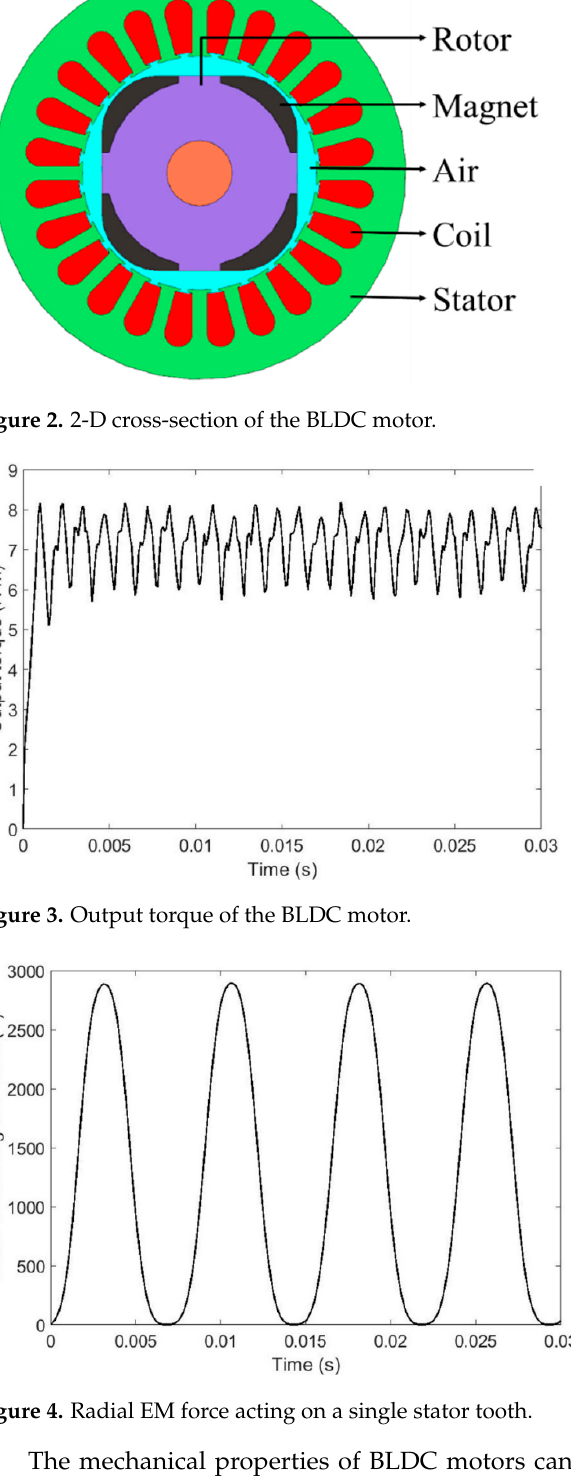
Figure 4. Radial EM force acting on a single stator tooth.